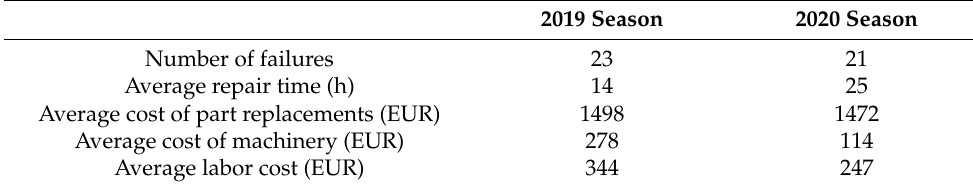
Table 2. Comparison of breakdown repair costs in 2019 and